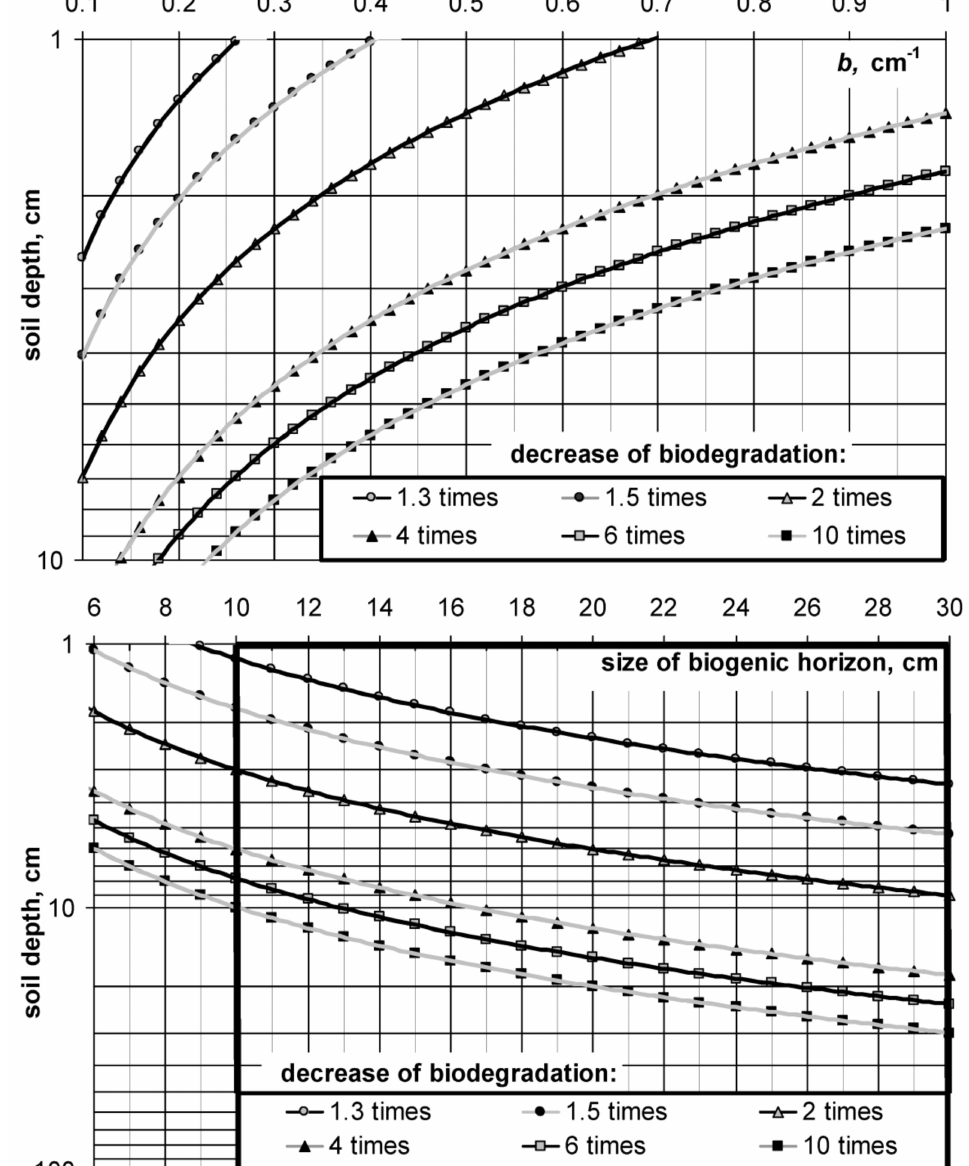
Figure 8. Nomographs for assessing the effect of deepening of organic soil-modifiers on their biodegradation in soils and soil constructions, according